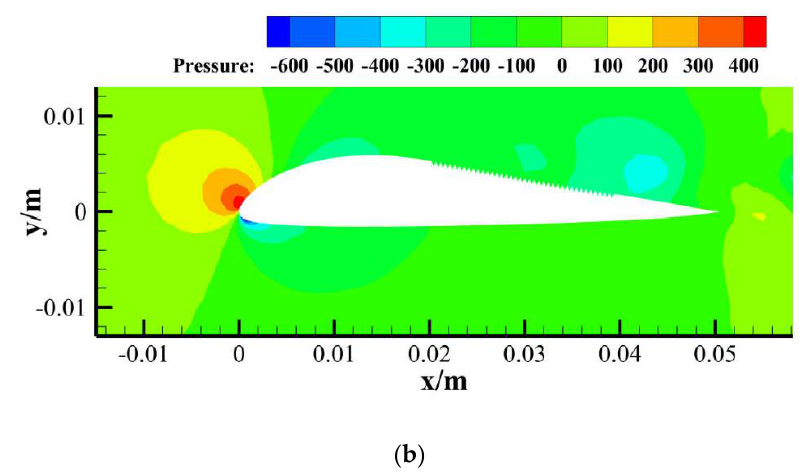
Figure 22. Comparison of the contours of pressure at 2.0 s between the two models: ( a ) the original hydrofoil and ( b ) the biomimetic hydrofoil.